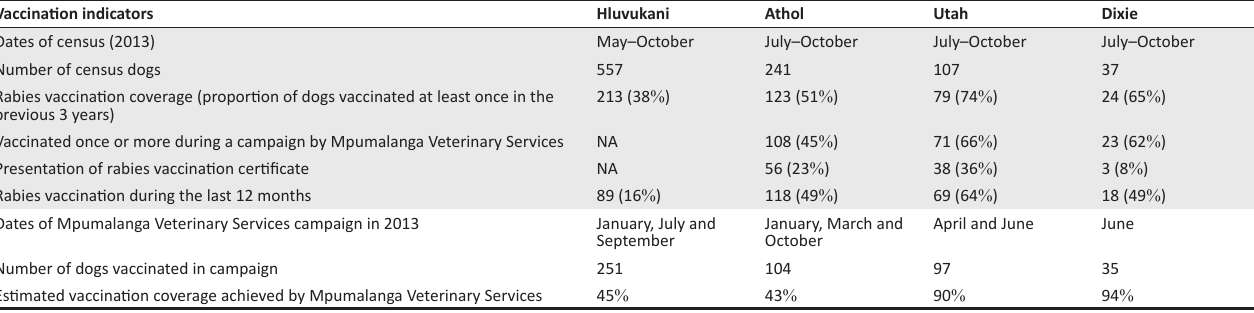
TABLE 2: Rabies vaccination coverage reported by owner or by Mpumalanga Veterinary Services. Vaccination